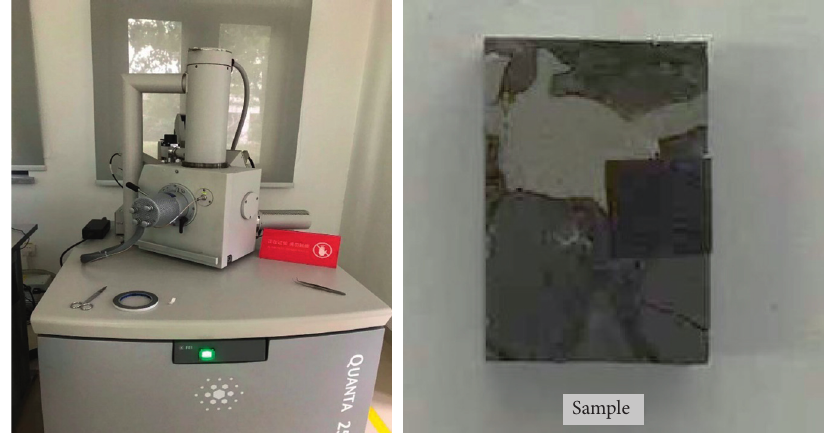
Figure 5: Samples and test setup of SEM-EDS test.